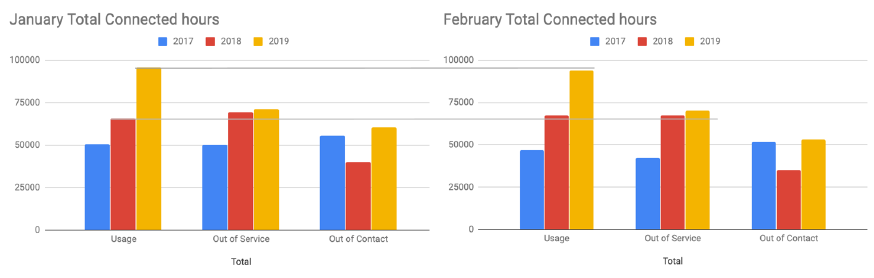
Figure 6. January/February comparison between three different years